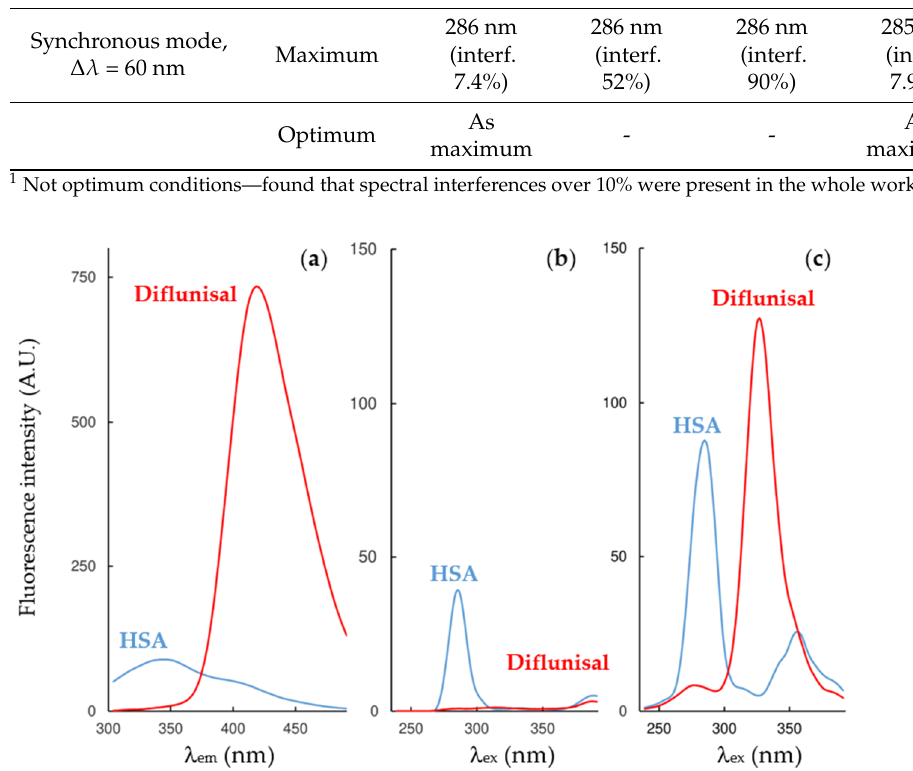
Figure 1. Comparison of fluorescence spectra in the study of diflunisal-HSA: ( a ) Emission; ( b ) synchronous ∆ λ 15 nm; ( c ) synchronous ∆ λ 60 nm modes at 25 °C.